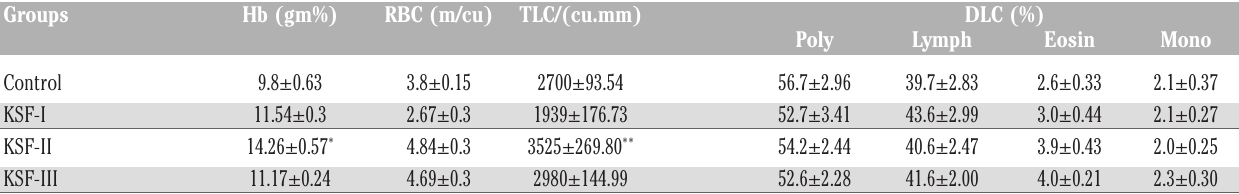
Table 1. Hematological changes produced by Kushta Sammulfar .